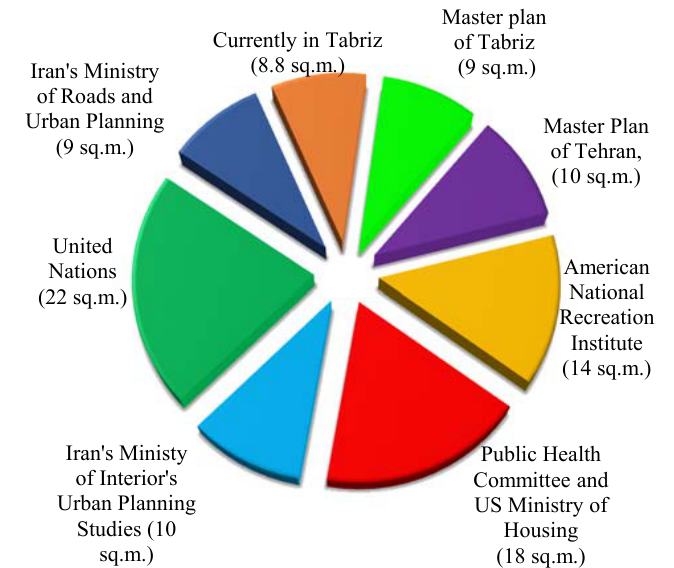
Fig 5: Comparison of per capita green space supply in Tabriz with the national and international standards